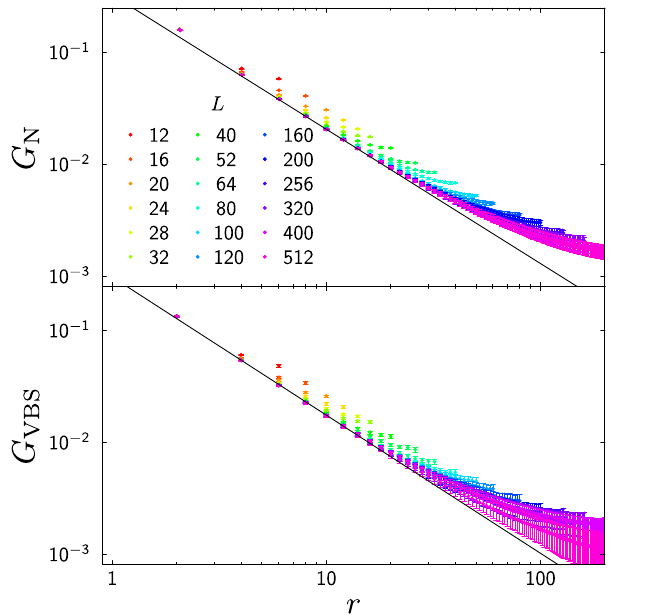
L Þ and η L Þ , N é el ð VBS ð